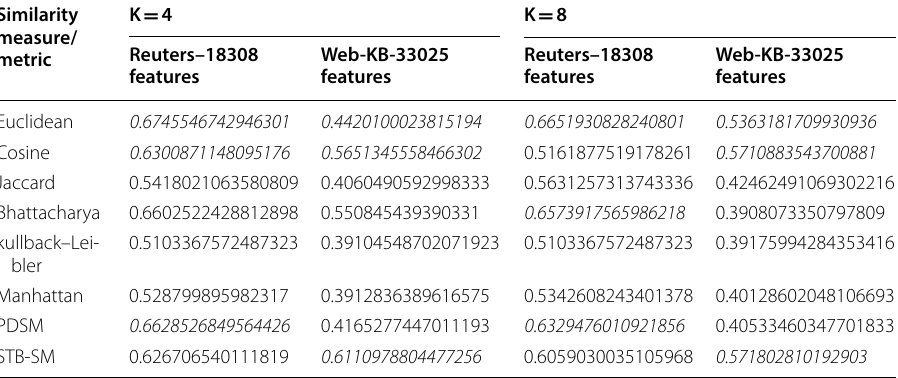
Italic values indicate the highest values that top measures achieved for corresponding evaluation metrics